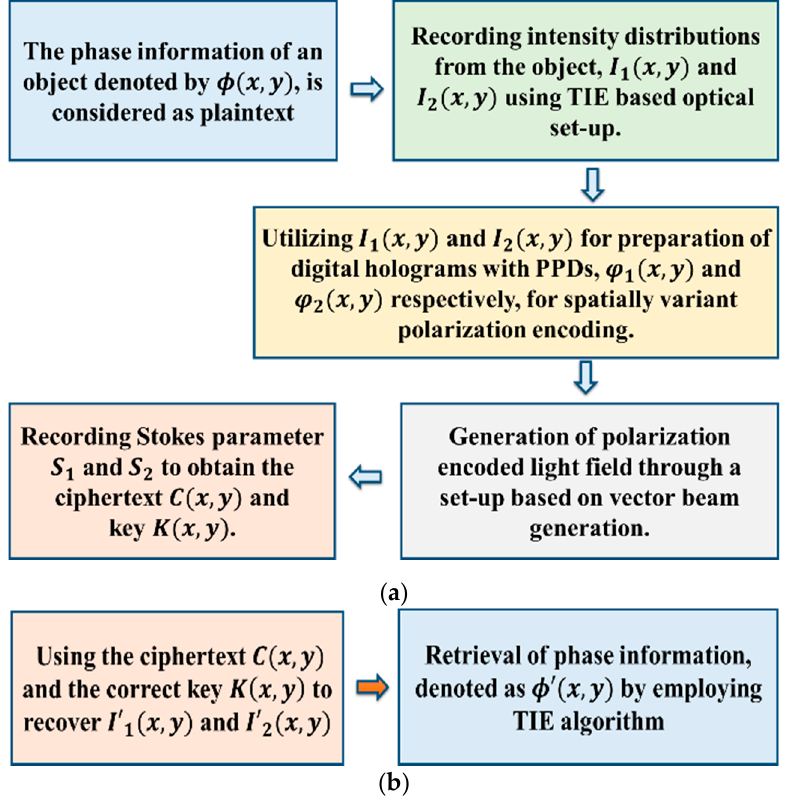
Figure 1. ( a ) Flowchart of proposed encryption and ( b ) decryption